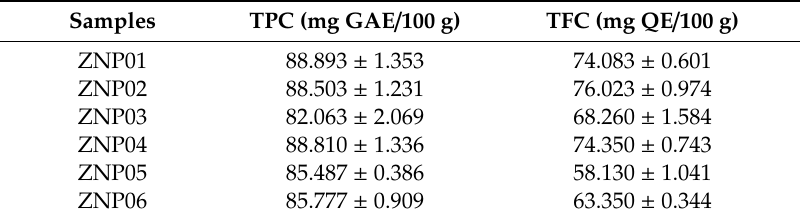
Table 1. Total phenolic content (TPC) and total flavonoids content (TFC) in crude methanol extracts of di ff erent genotypes of Z.